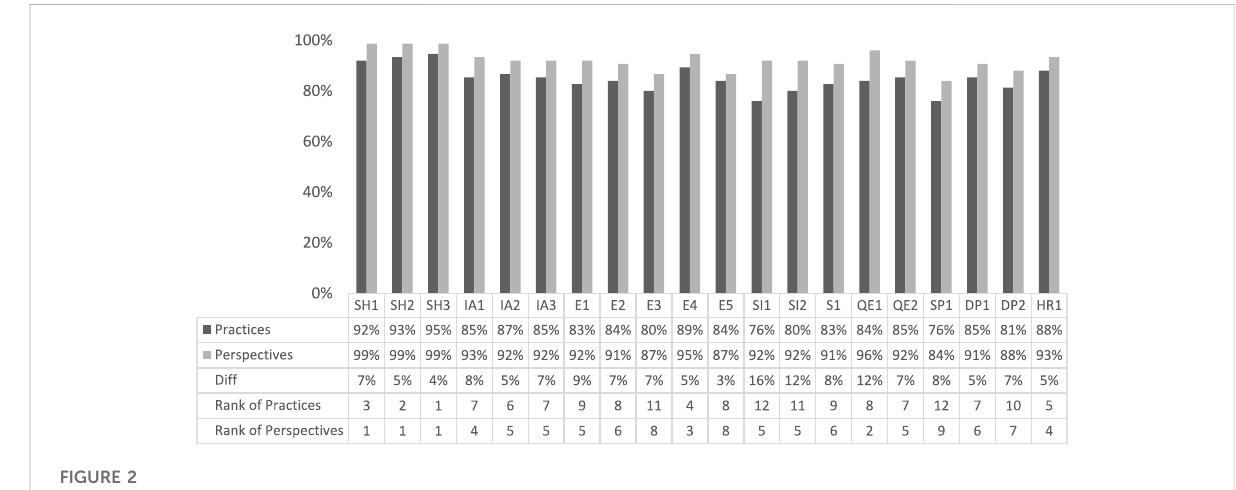
FIGURE 2 Gap of Social Sustainability Attributes (Practice versus